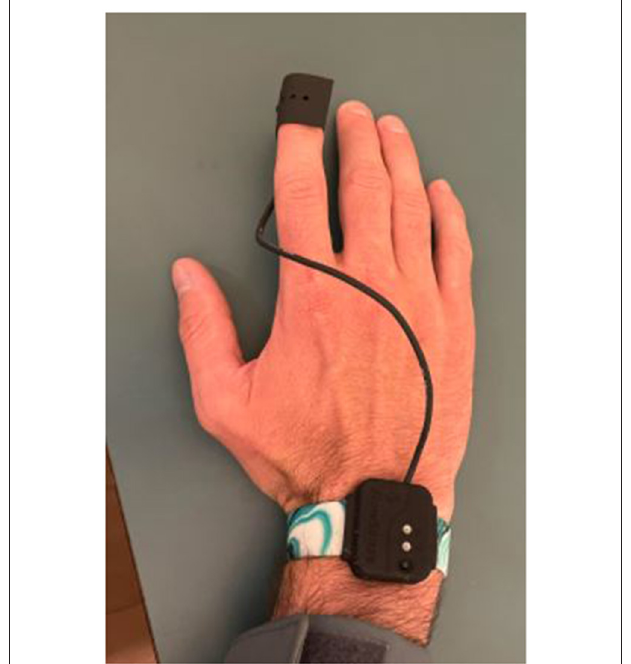
FIGURE 1 | Capillary refill